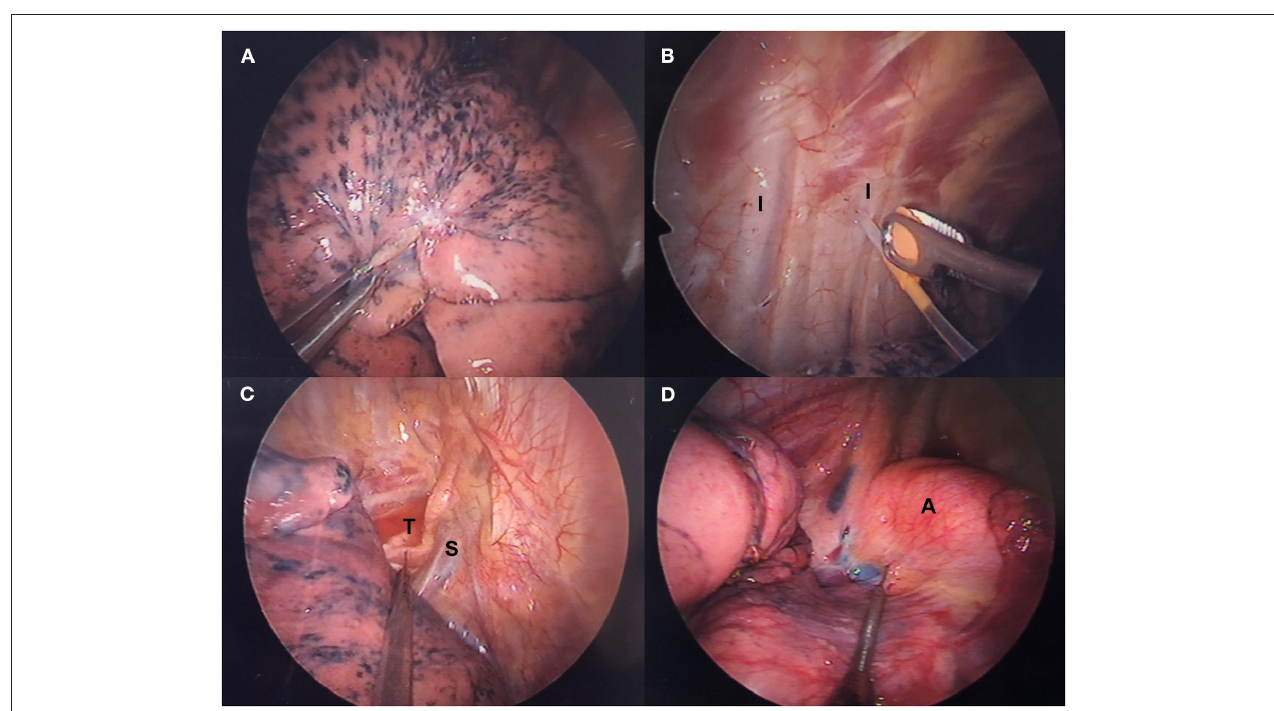
FIGURE 2 | Thoracoscopic intercostal nerve blocks and vagal nerve block. (A) Lung collapses gradually after iatrogenic pneumothorax. (B) Intercostal nerve blocks are administered with a 25-G top-winged infusion needle under thoracoscopic guidance. (C) Right-sided and (D) left-sided intrathoracic vagal nerve block in accordance with the operative side. A, aortic arch; I, intercostal nerve; S, superior vena cava; T, trachea.